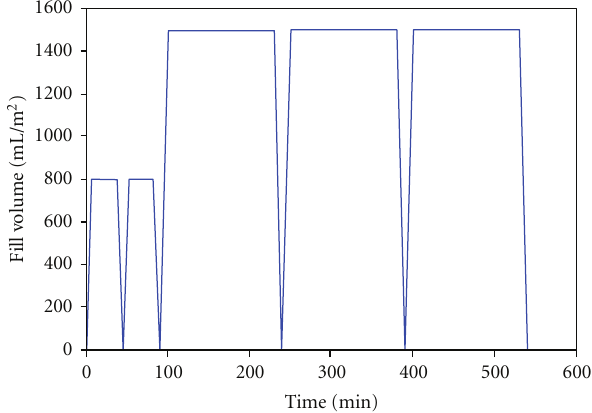
Figure 4: Example of an adapted PD session. Short dwells of 45 minutes of dwell time (i.e., individual APEX time) with a small fill volume (800mL/m 2 ) favoring ultrafiltration by a high osmotic gradient at a low IPP are followed by long dwells (150 minutes; 3- 4 times the APEX time) with a large fill volume (1500mL/m 2 ), to promote uremic toxin